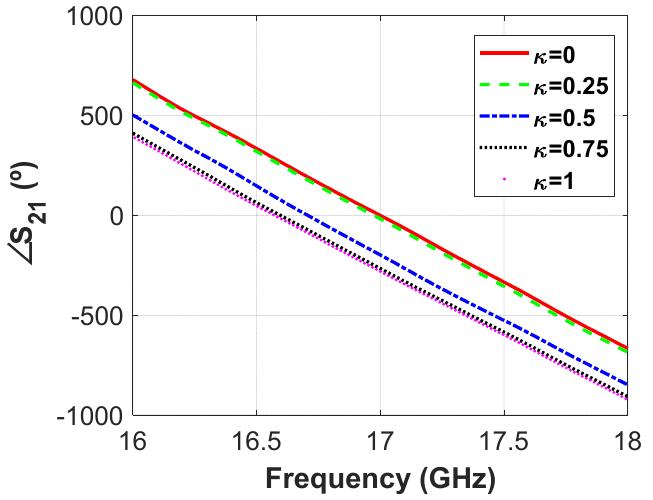
Figure 7. Measured phase shift produced by one of the WRPS for different values of TS (tuning screw) penetration.